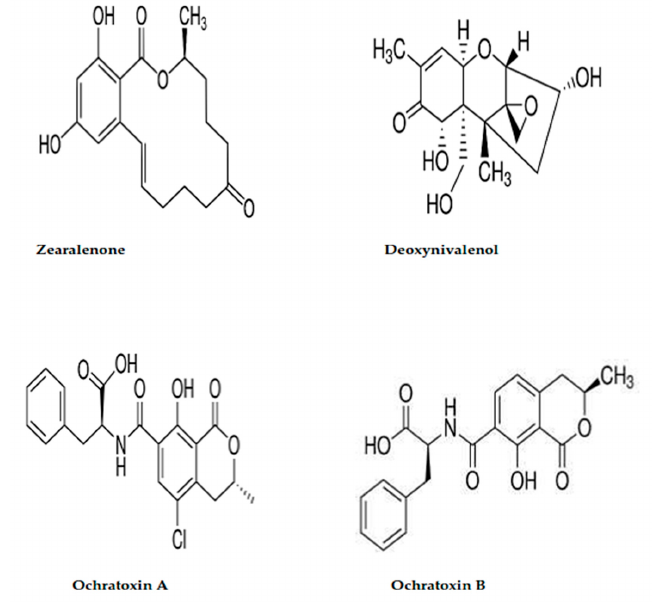
Figure 5. Chemical structure for ochratoxins ( A , B ), deoxynivalenol, and zearalenone.